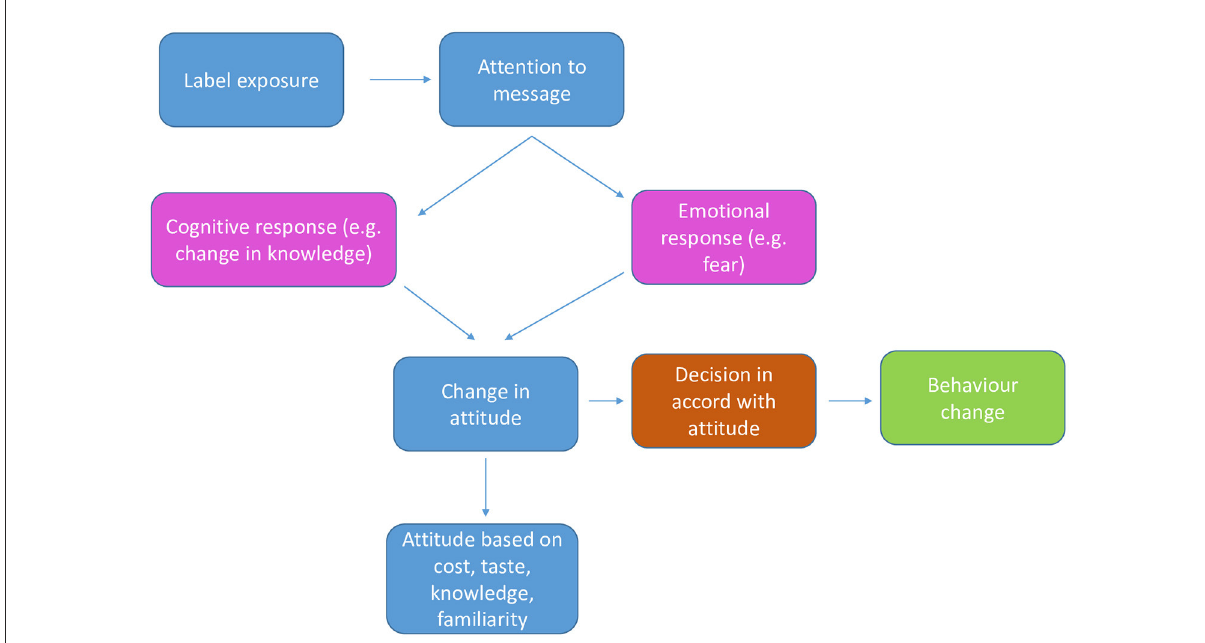
FIGURE1 Conceptual framework that explains influence of warning label on food purchasing behavior.